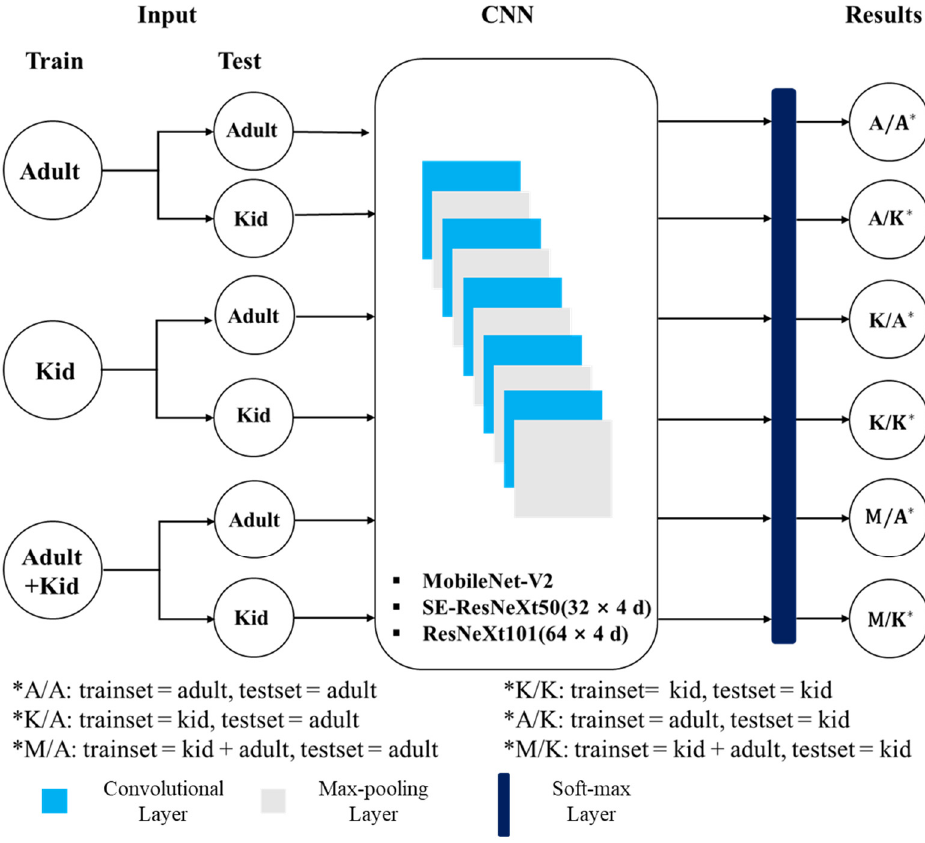
Figure 2. Schematic diagram of the experimental sequence.